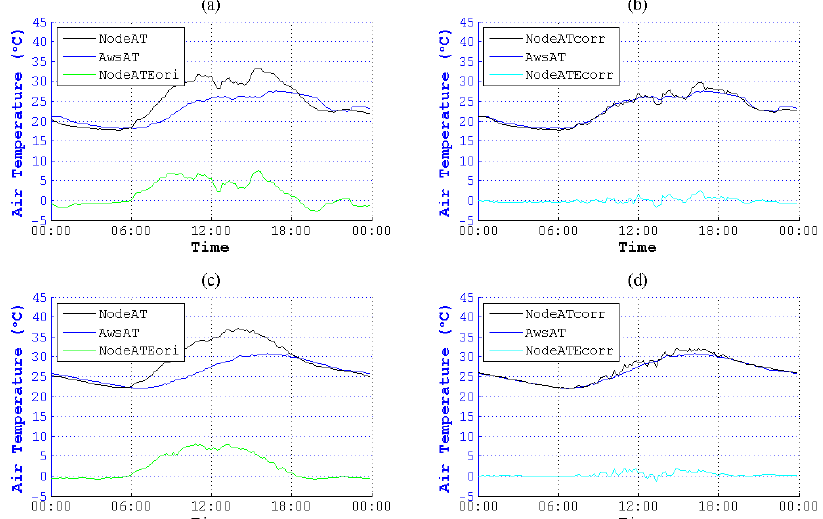
Figure 11. Contrast of NodeAT and NodeATcorr on 4 June 2014 and 9 June 2014.